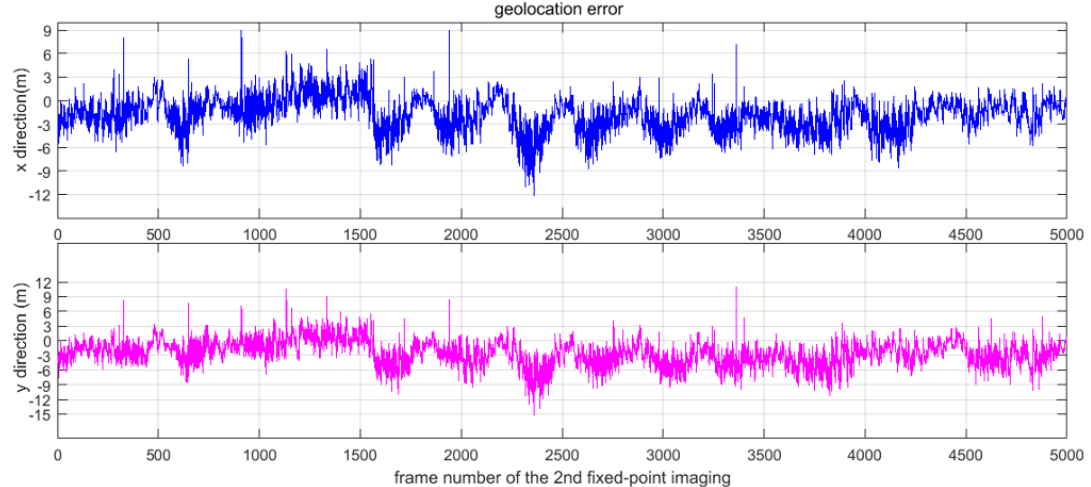
Figure 9. Target positioning accuracy in X and Z directions for the second fixed ‐ point imaging.